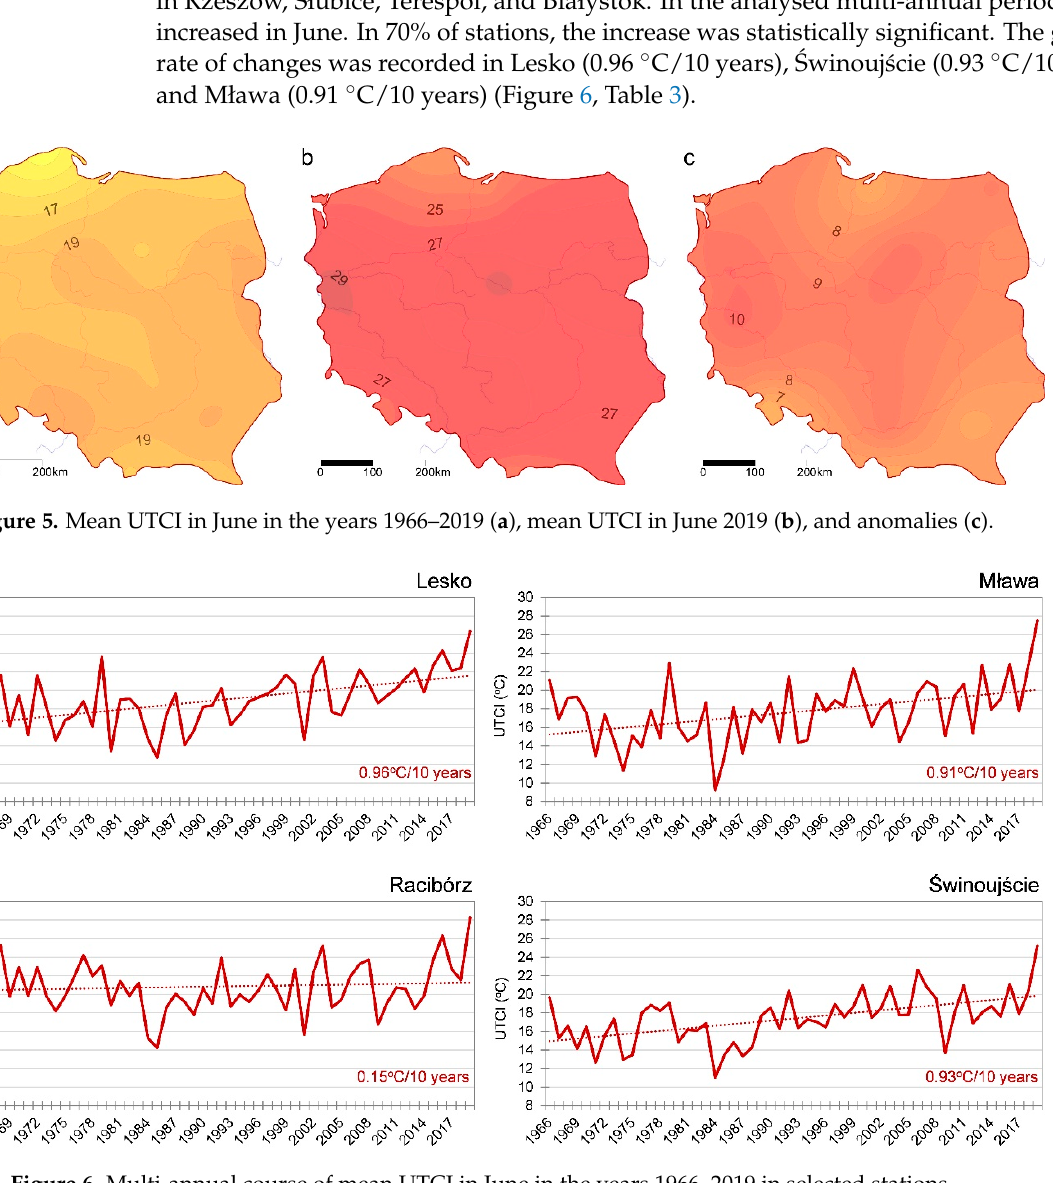
Figure 6. Multi-annual course of mean UTCI in June in the years 1966–2019 in selected stations.